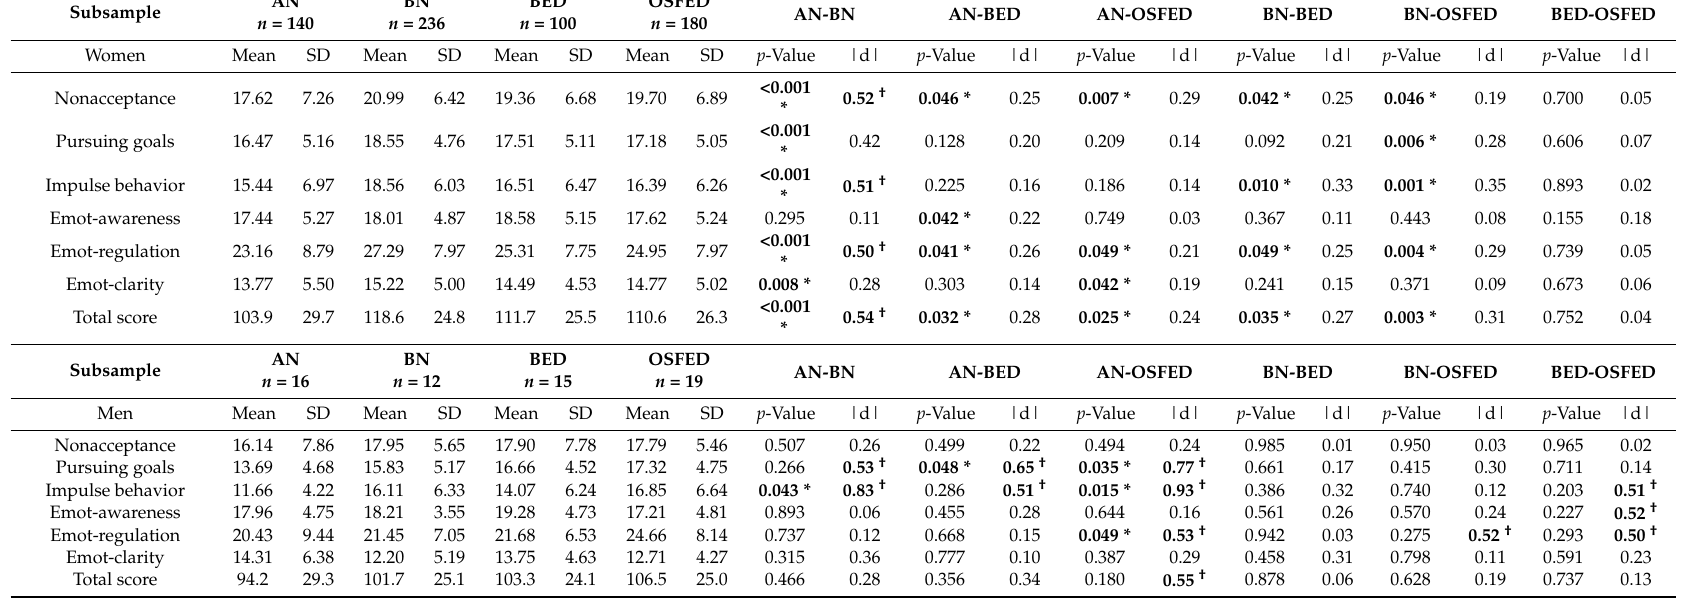
Table 3. Comparison of DERS scales between diagnostic subtypes: ANOVA adjusted for age, civil status, and